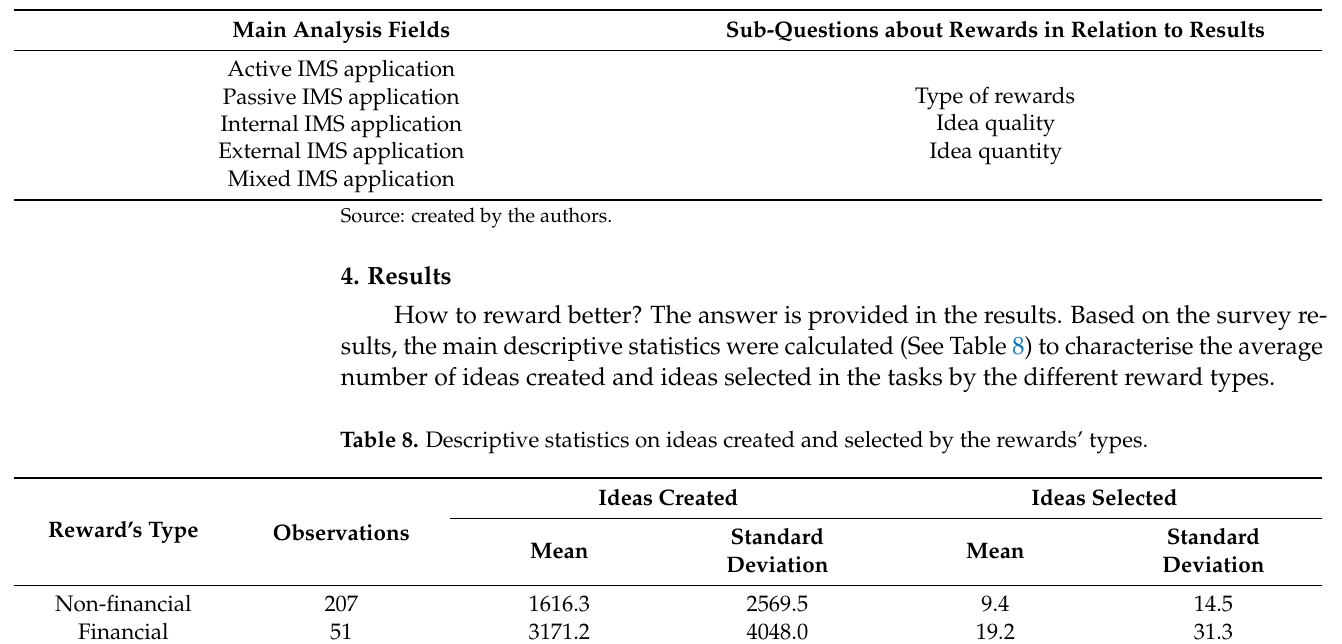
Table 7. Databases analysis.